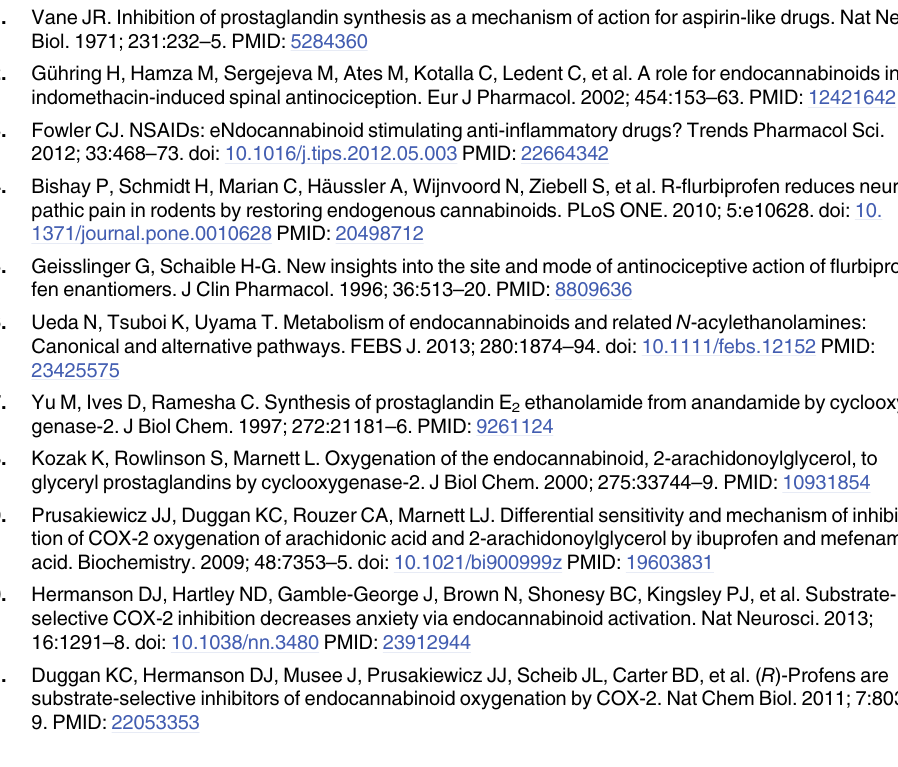
S2 Fig. Recovery rates of lipids used as internal standards spiked to RAW 264.7 cell extracts and to phosphate-buffered saline (PBS). Internal standard recovery rates were determined as described in Materials and Methods. Shown are means ± s.e.m. for five determinations. S3 Fig. Effects of FAAH and/or COX inhibitors upon the levels of linoleic acid-derivatives in ionomycin-treated RAW264.7 cells pretreated with LPS + IFN γ for 24 h. RAW264.7 mouse leukemic cells (2.5x10 5 per well) were added to 6 well-plates with LPS (0.1 μ g/mL well) and INF- γ (100 U/mL) and cultured at 37°C for 24 h. prior to incubation for 30 min with iono- median value for each lipid and batch for vehicle-treated conditions were set to unity and all other values for the batch were expressed relative to these median values. Data are shown as scatter plots (n = 18), with the median values shown as bars. (cid:3) P < 0.05, Dunn ’ s Multiple Com- parison test vs . vehicle (otherwise not significant) following significant Kruskal-Wallis test. S1 Table. List of abbreviations of the lipids reported for the RAW264.7